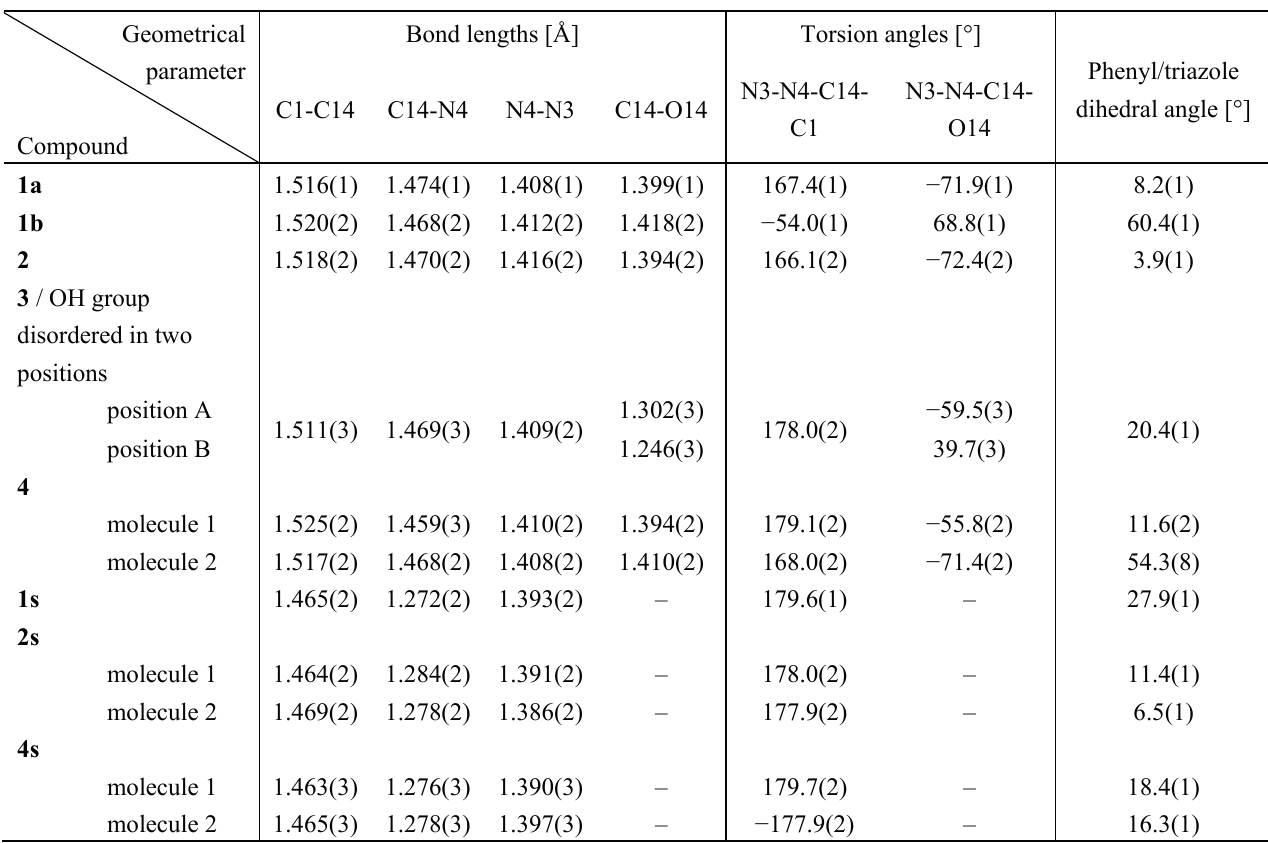
Table 1. Selected geometrical parameters for hemiaminals ( 1a , 1b , 3 , 4 ) and corresponding imines ( 1s , 2s , 4s